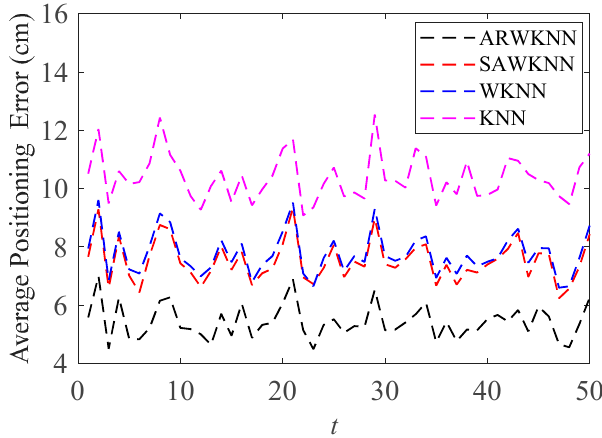
Figure 17. In 3-D, the impact of SR on the average positioning error with K max = 8.